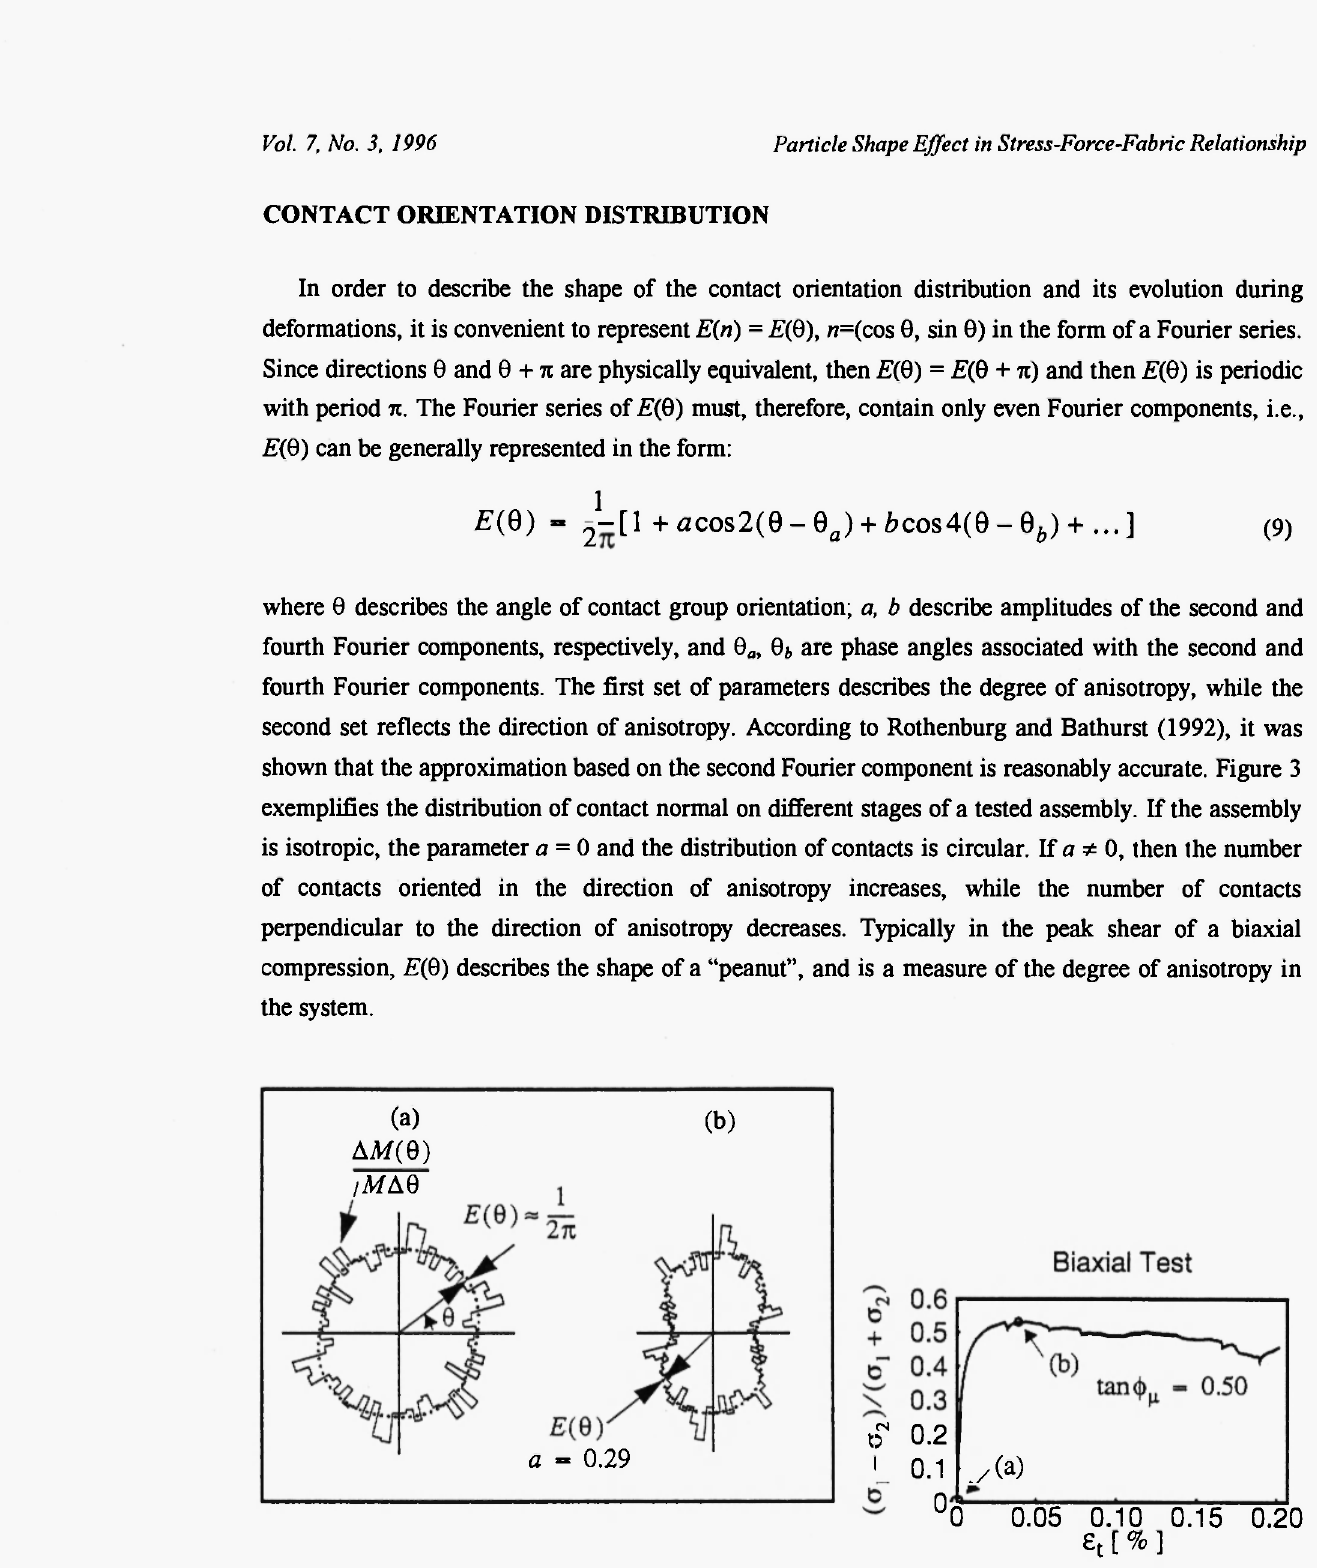
Fig. 3: Distribution of contact normals: (a) initial distribution of contact normals; (b) distribution of contact normals at peak shear in biaxial